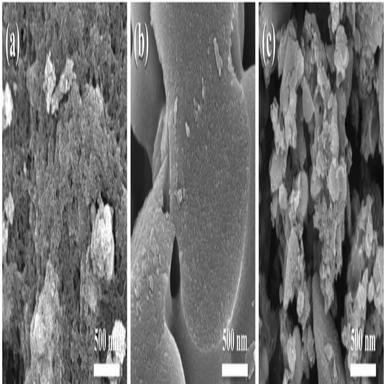
SEM images after carbonization (a) WM-SC; (b) WM-NC; and (c) WM-TOC.